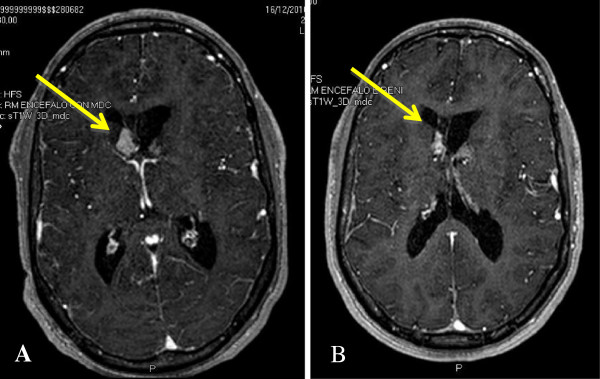
SEGA volume reduction during Everolimus treatment. A boy with a TSC2 mutation showed progressively growing SEGAs that caused a first acute hydrocephalus when he was 17 years old. He therefore underwent a partial resection of the lesion, with hydrocephalus resolution. However, two years later, the contralateral SEGAs determined a new episode of hydrocephalus and he underwent surgery once again. However, both lesions presented a slow regrowth after surgeries, and figure (A) shows their aspect when the boy was 24 years of age. He later presented a new episode of subacute hydrocephalus, which required an external derivation. He subsequently started Everolimus treatment, with a partial response (total lesion volume 46% of baseline) of SEGAs after 12 months of treatment (B).